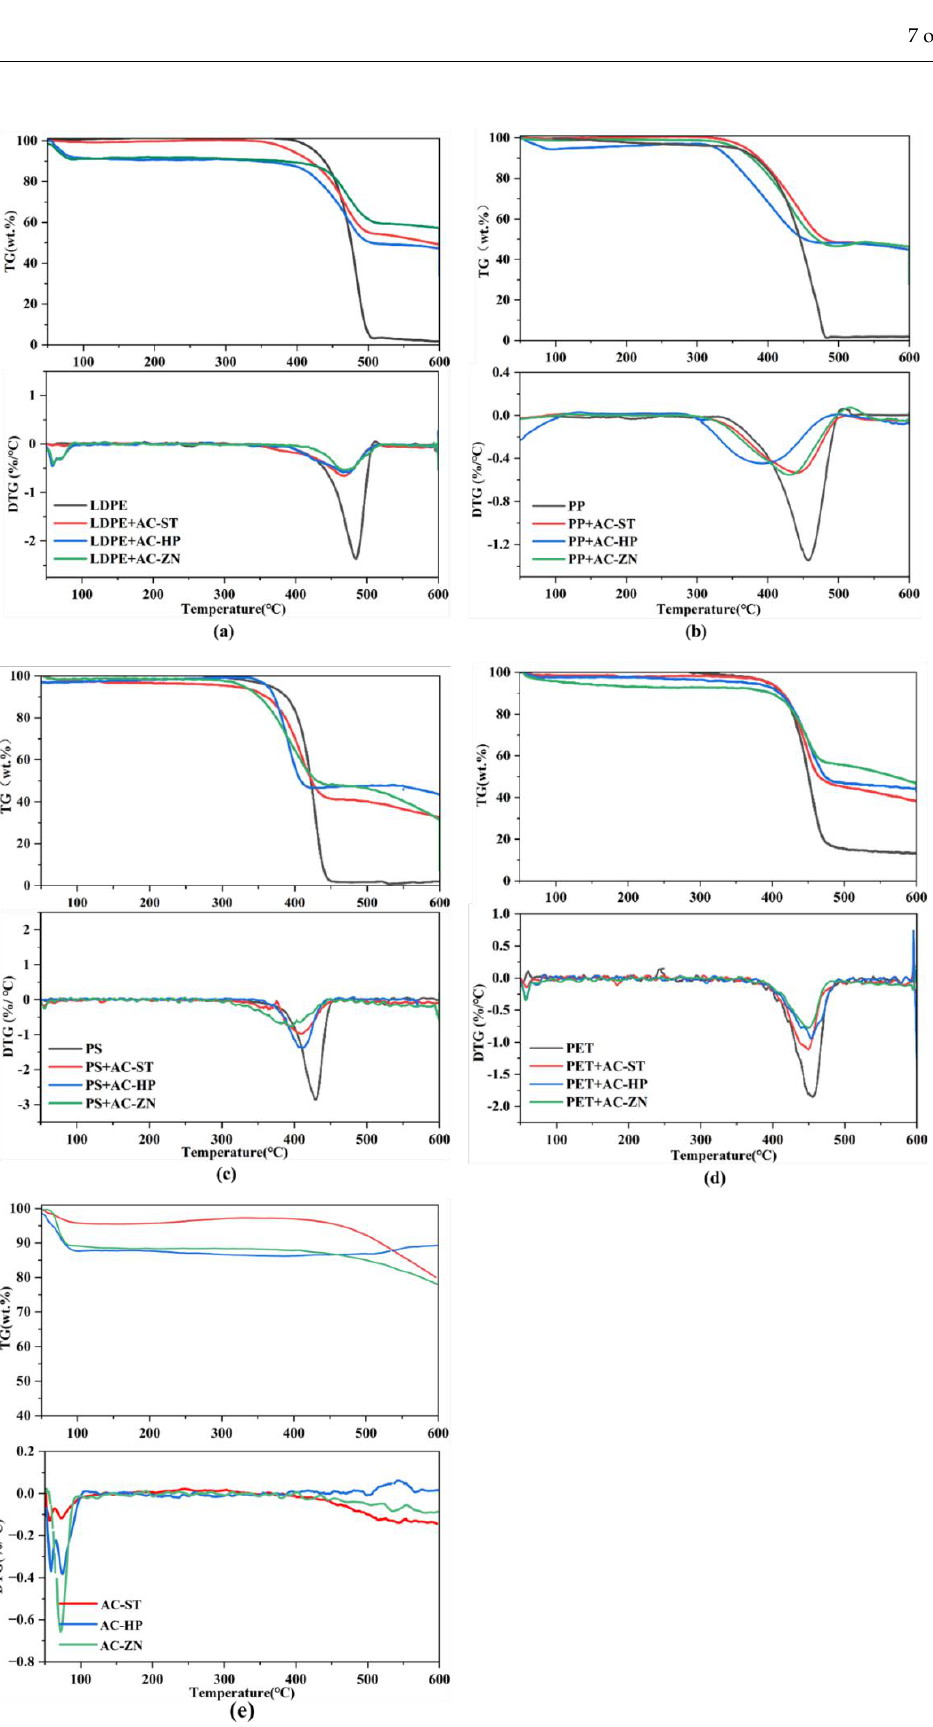
Figure 3. The TG and DTG curves of ( a ) LDPE, ( b ) PP, ( c ) PS, ( d ) PET, and ( e ) carbon catalyst thermal pyrolysis and catalytic pyrolysis with carbons. Conditions: heating rate = 10 °C/min; N 2 atmosphere; carbon 10 mg and plastic 10 mg.